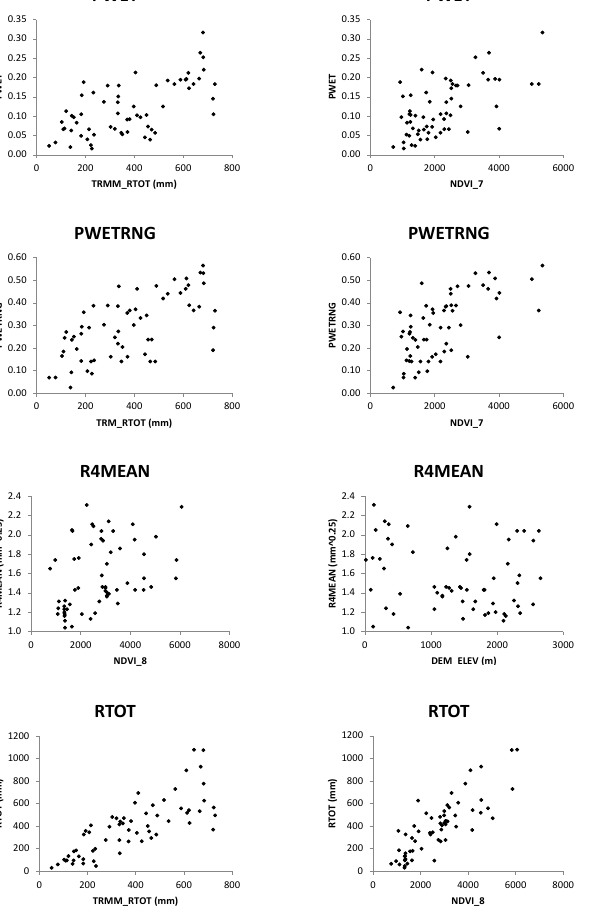
Fig. 6. Example relationships between daily precipitation parame- ters for Network A and selected predictor variables: TRMM(V7), NDVI, and